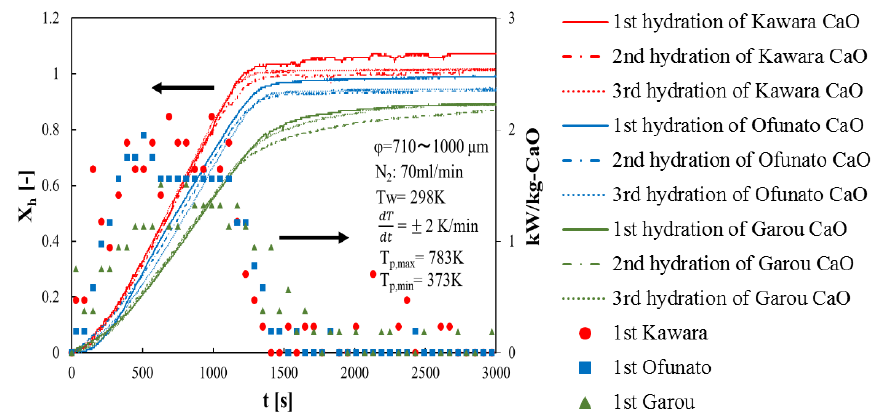
Figure 4. Hydration conversion and the heat output of Kawara CaO, Ofunato CaO and Garou